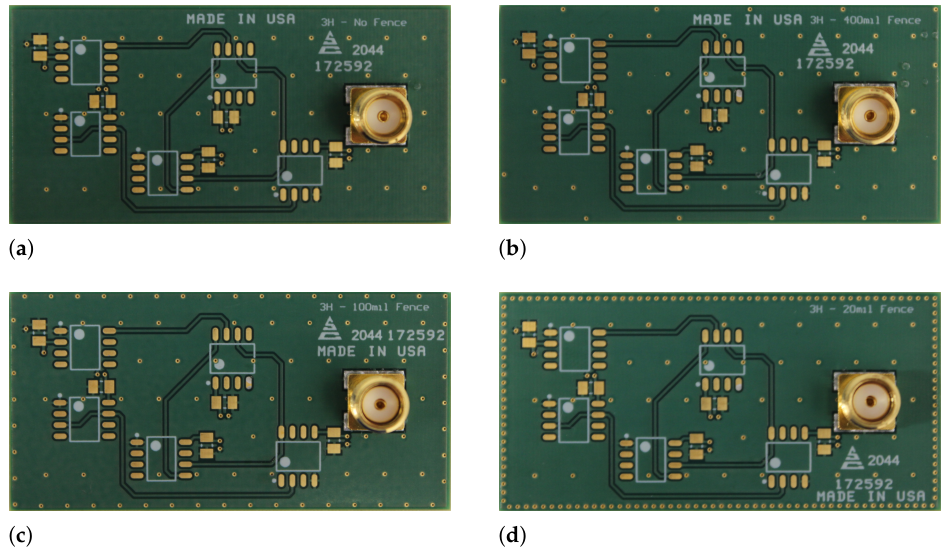
Figure 10. Variations in via fencing density around the perimeter of the fabricated PCBs: ( a ) no via fence, ( b ) 400mil via spacing, ( c ) 100mil via spacing, and ( d ) 20mil via spacing. Note that in all cases, via stitching is present internal to the board to tie all ground layers together.